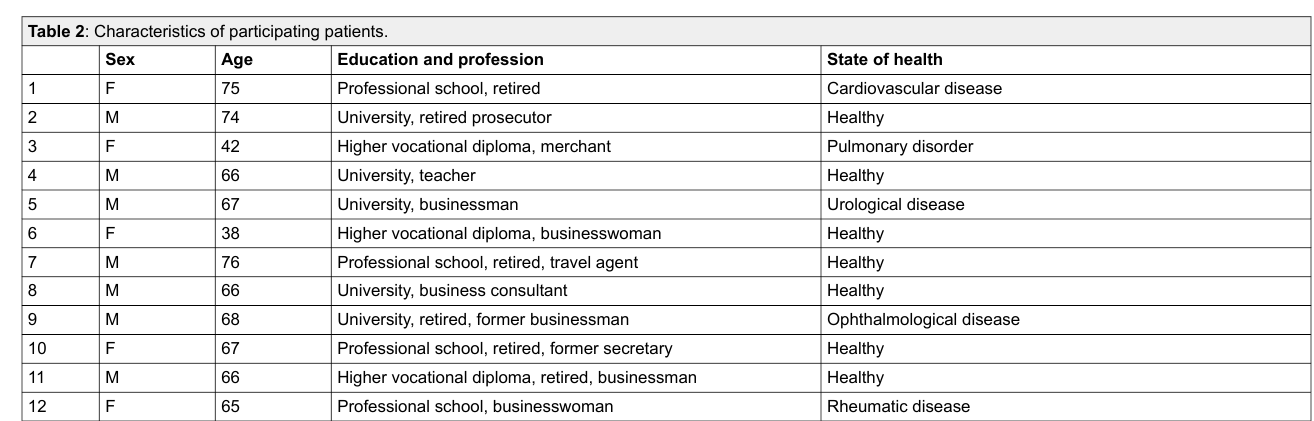
Table 2 : Characteristics of participating